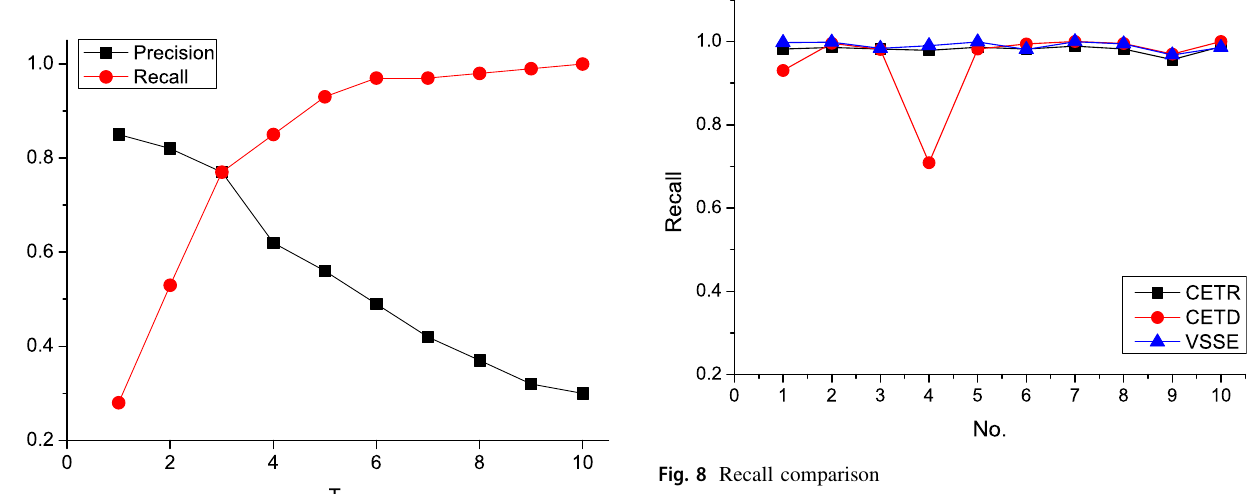
Fig. 5 Recall, precise and F 1-score on different T 1